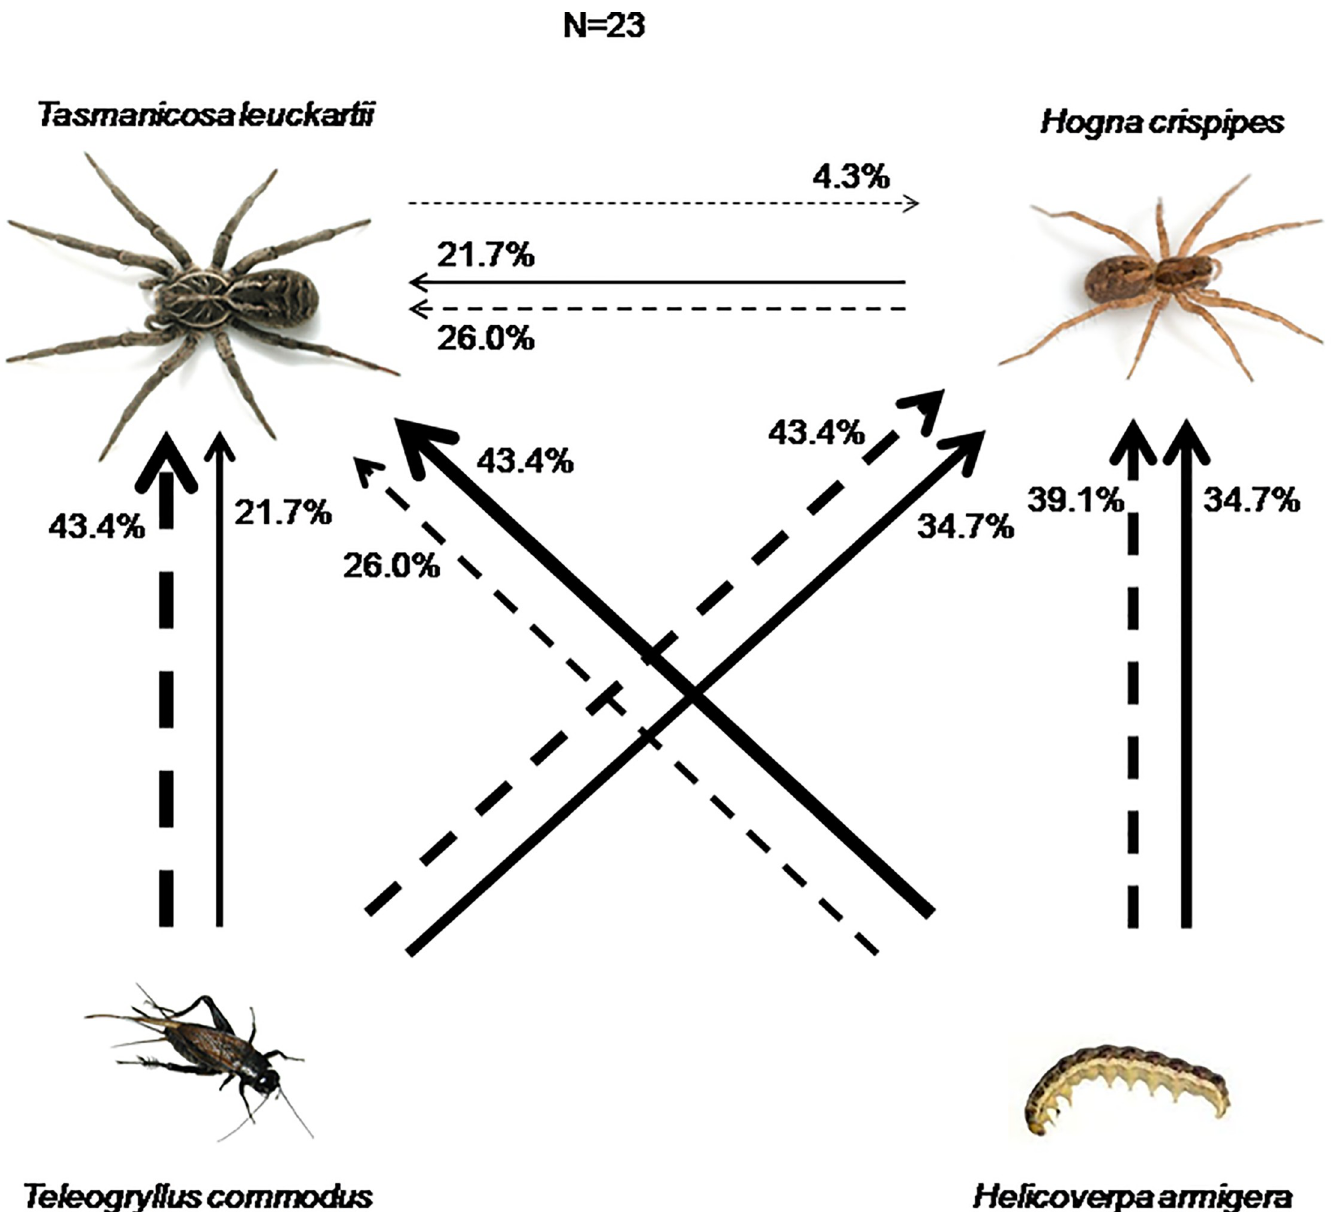
Fig 2. Percentages of first encounter (dashed arrows) and first attack (solid arrows) of Tasmanicosa and Hogna in a four-way videorecorded food web arena. Direction of arrows point to the predator that made the encounter/attack, thicker arrows represent higher proportions. Percentages indicate cases in which prey was encountered first (out of n = 23), or attacked first (out of n =